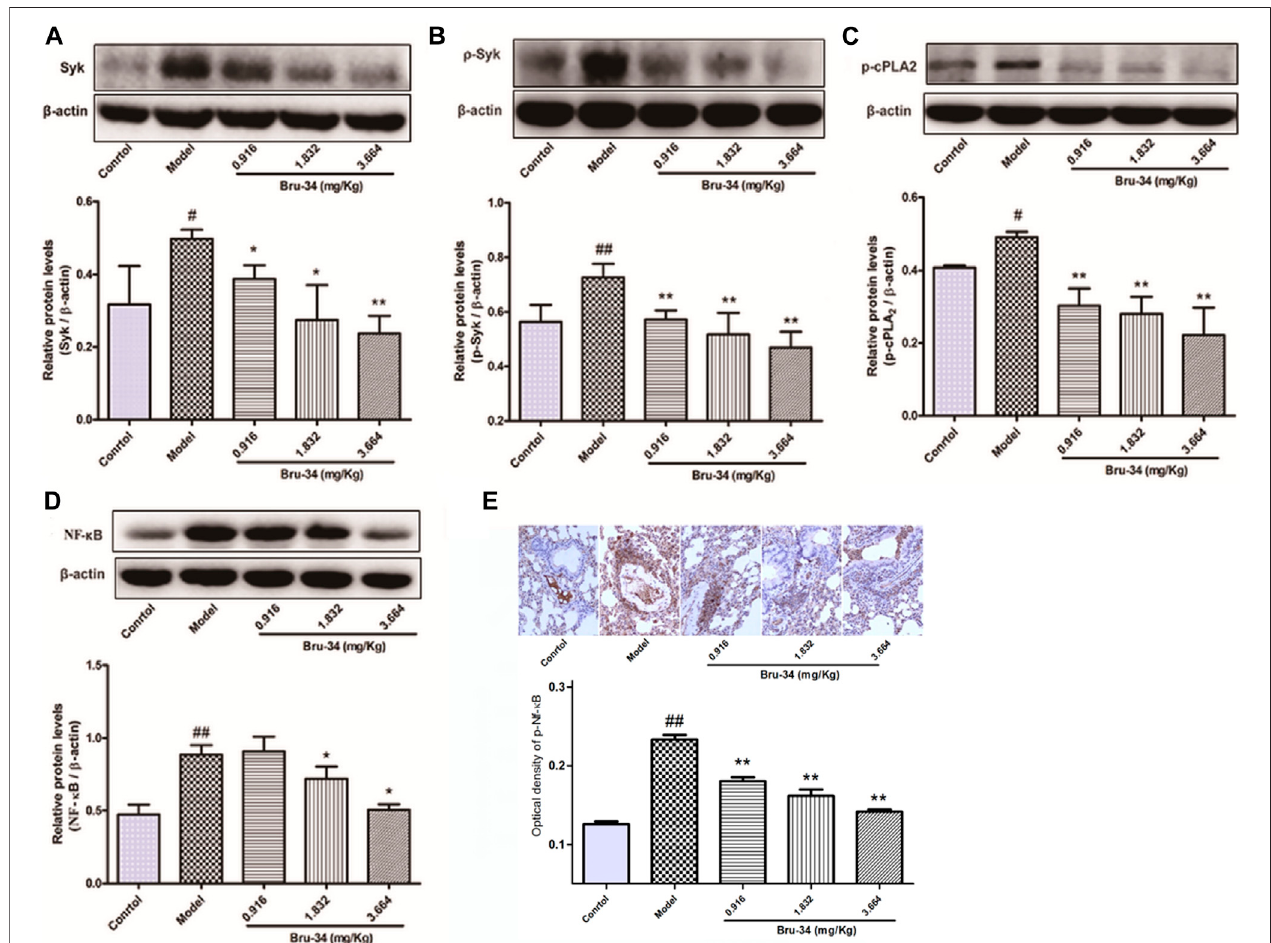
FIGURE4| TheeffectsofBru-34onSyk,cPLA2andNF- κ Bexpressionandactivation invivo .Panel (A) :thelevelofSykdeterminedbyWesternblotting;Panel (B) : the level of p -Syk determined by Western blotting; Panel (C) : the level of p -cPLA2 determined by Western blotting; Panel (D) : the level of NF- κ B determined by Western blotting; Panel (E) : the level of p-NF- κ B were determined by immunohistochemistry - staining; Data were given as mean ± S.D. (n (cid:2) 3).